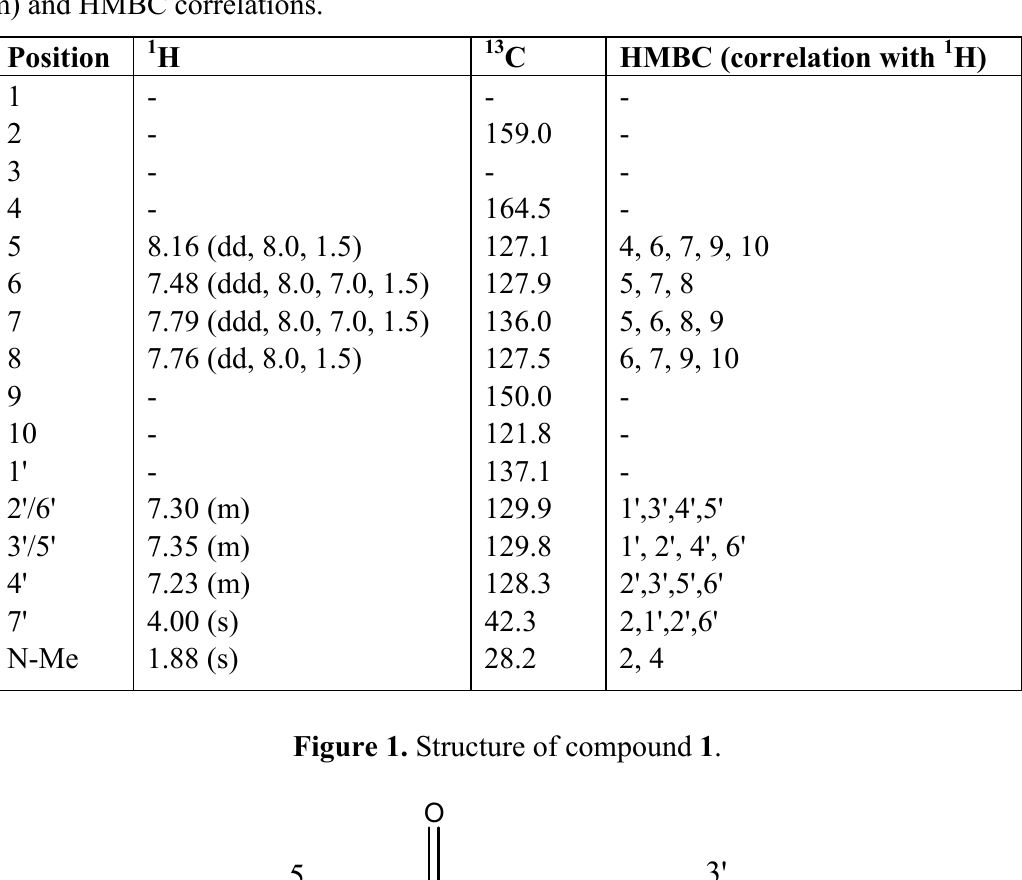
OD, J in Hz and δ in 3